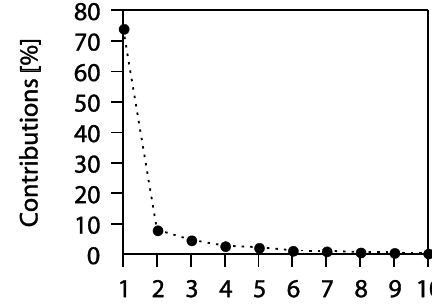
Fig. 1. Percent variances for the first ten Figure 1. Percent variances for the first ten mode. 402